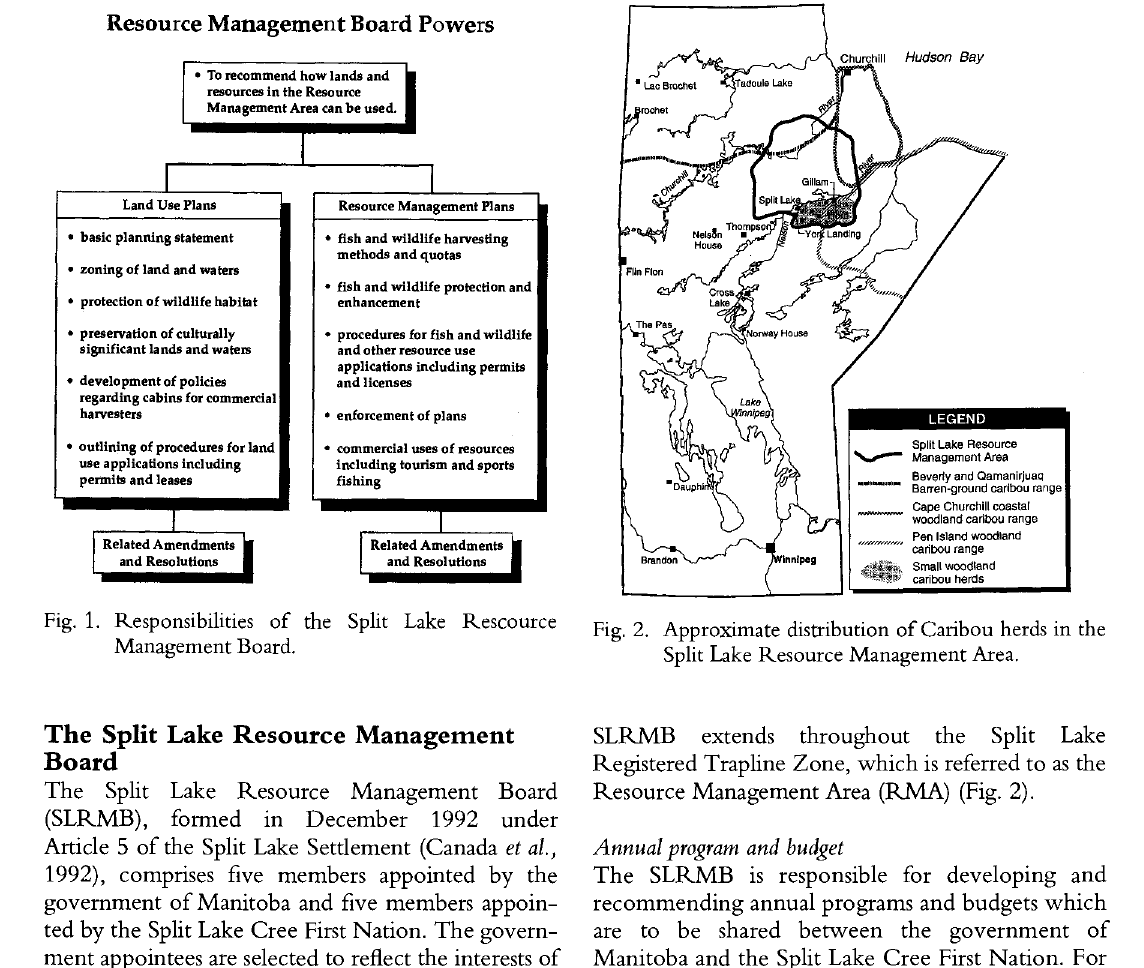
Fig. 2. Approximate distribution of Caribou herds in the Split Lake Resource Management